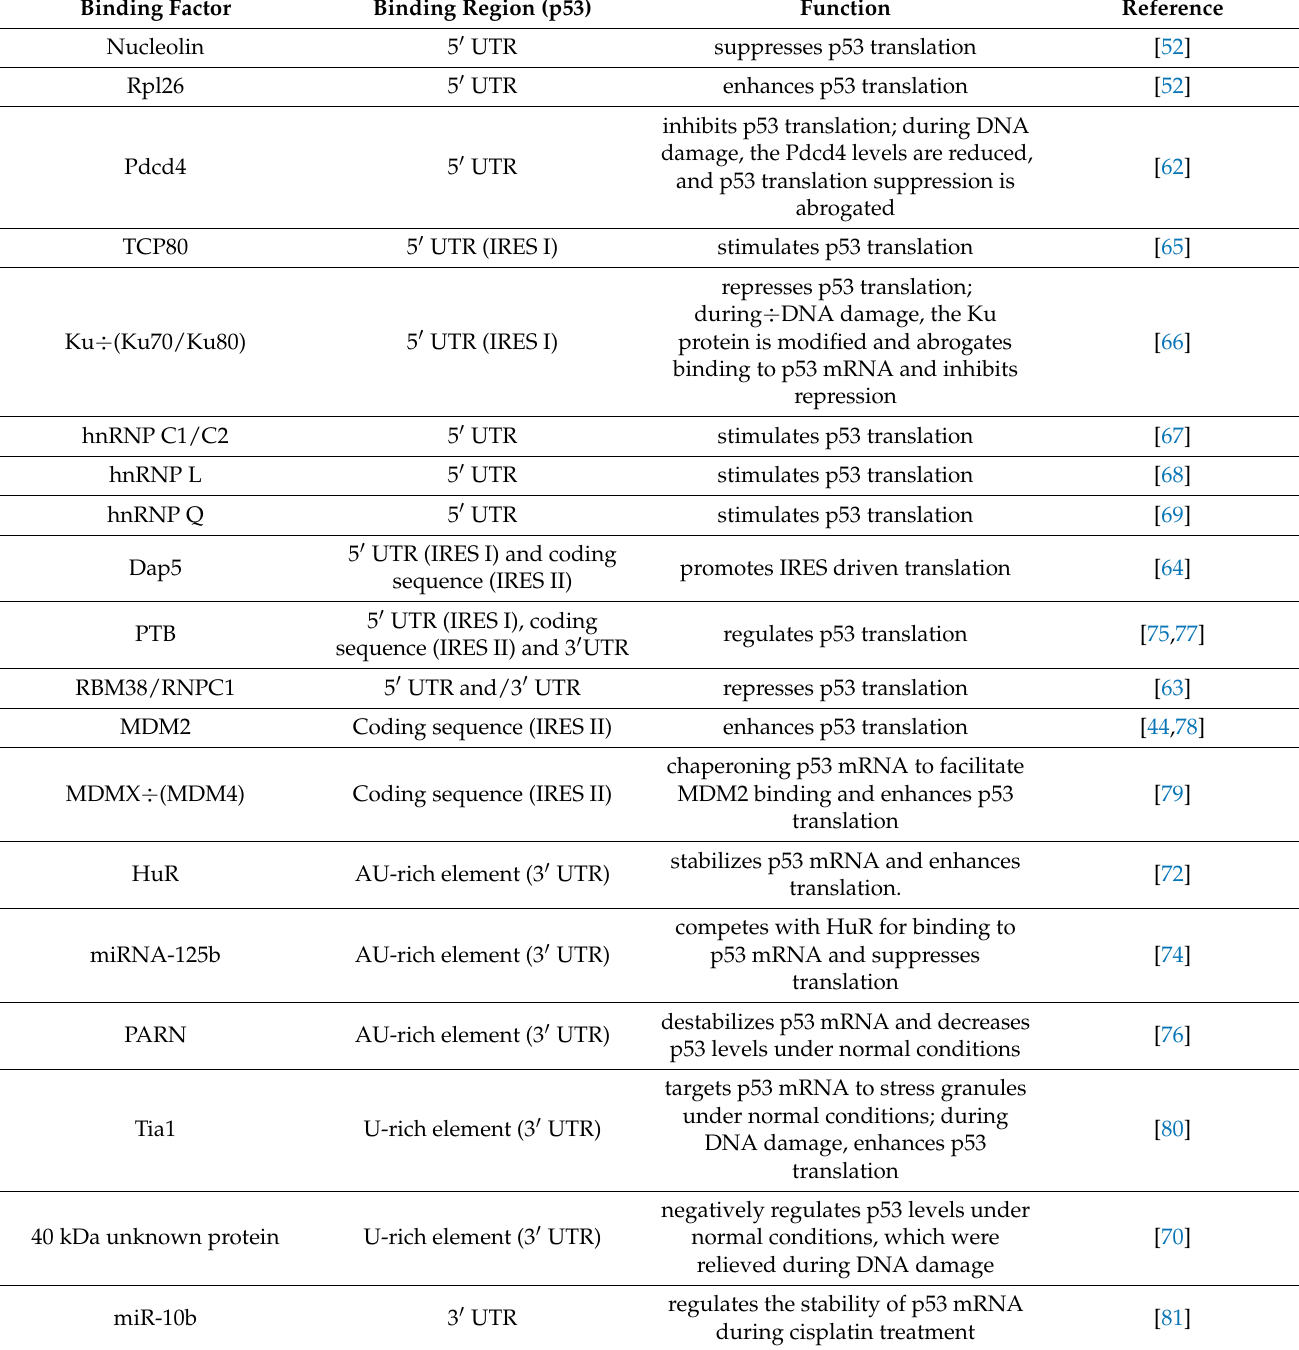
Table 1. Summary of different p53 mRNA regions involved in